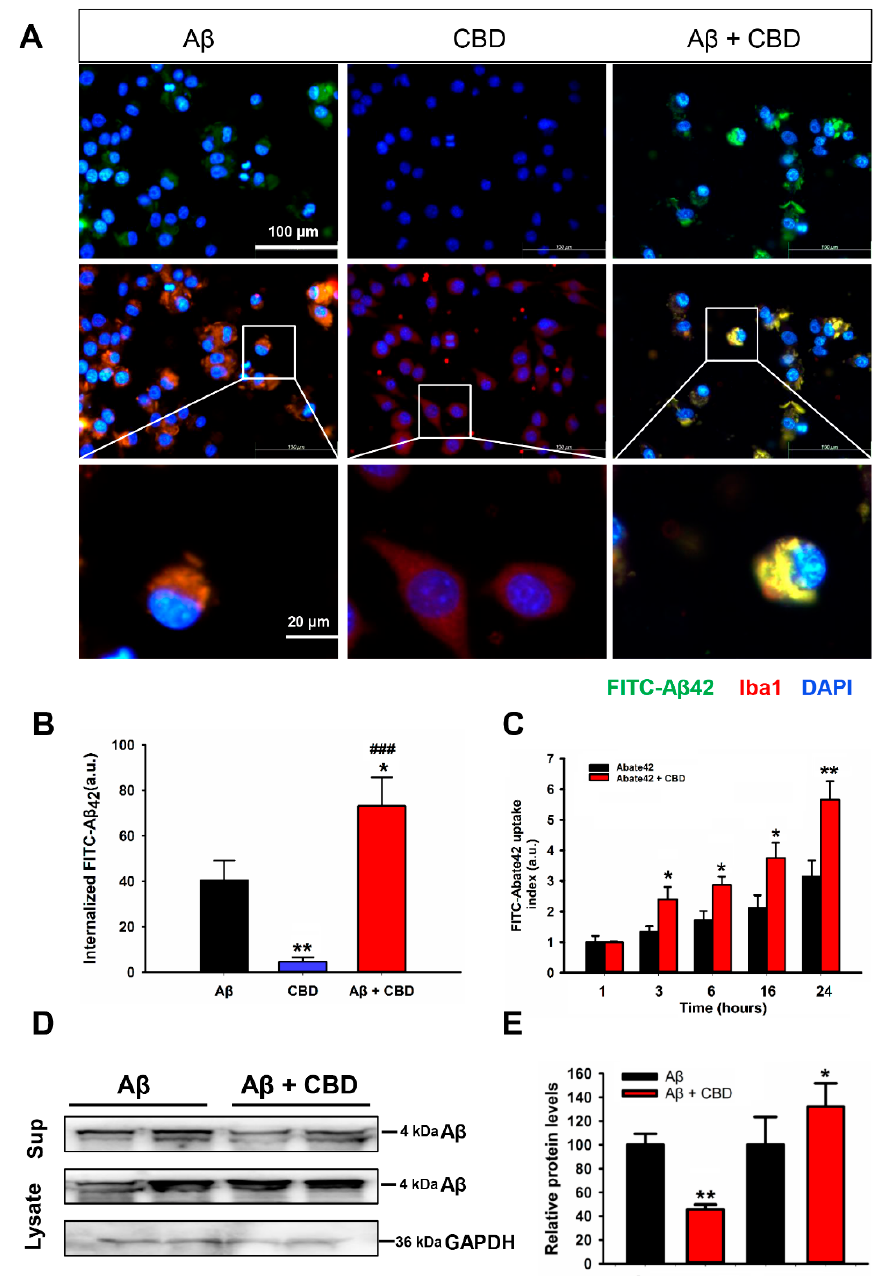
Figure 2. CBD enhanced microglial A β phagocytosis via the TRPV2 channels. ( A ) Primary microglia cells were plated at a density of 5 × 10 4 in poly ‐ D ‐ lysine ‐ coated wells of 24 ‐ well plates containing 10% FBS DMEM medium. After 24 h of treatment with CBD (5 μ M), FITC ‐ A β 42 (1 μ g/mL) was added to the medium. Immunofluorescence analysis of the microglial phagocytosis of FITC ‐ A β 42 was performed after allowing uptake for 4 h in microglia cells. ( B ) Quantification of the internalized FITC ‐ A β 42 using ImageJ software ( n = 36 to 42 per group). a.u., arbitrary units from 3/4 individual mice. ( C ) FITC ‐ A β 42 uptake index in the presence or absence of CBD after uptake for the indicated time in microglia cells, calculated based on the phagocytosis assay. ( D ) Microglial A β 42 uptake was analyzed using Western blotting after 4 h of incubation with A β 42 oligomer in the presence or absence of CBD. ( E ) Quantification of the protein levels using Image J software ( n = 4 per group). * p < 0.05 and ** p < 0.01 are compared with the A β by the Student’s t ‐ test; ### p < 0.001 between A β and CBD + A β by Student’s t ‐ test. The scale bars = 20 μ m.